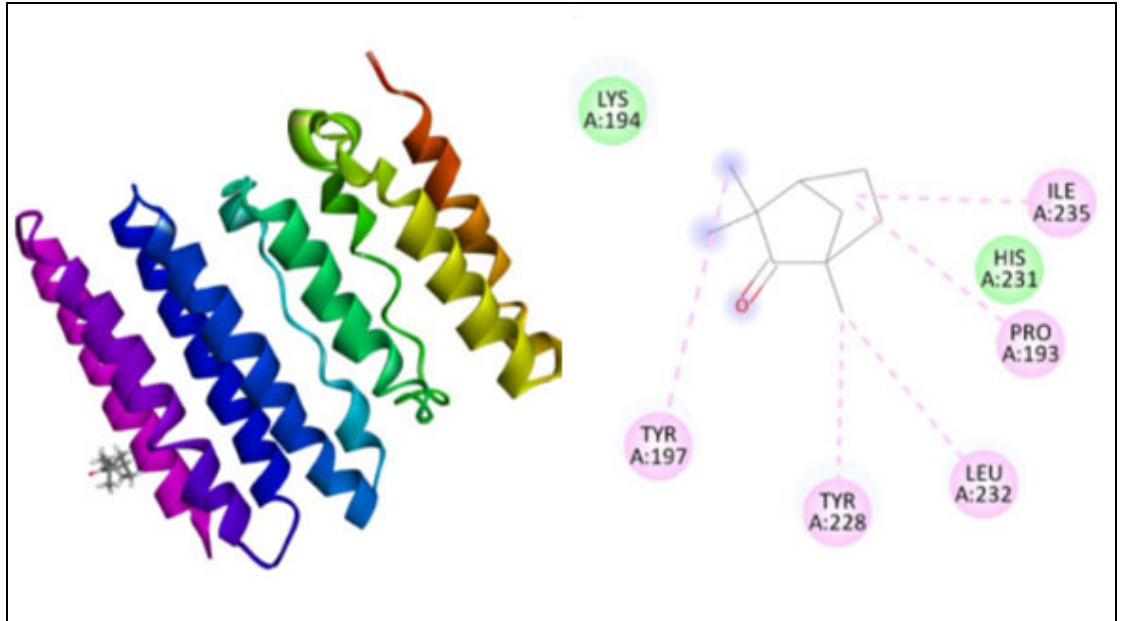
Figure 5. Interaction of Anthranilate ‐ CoA ligase with fenchone.